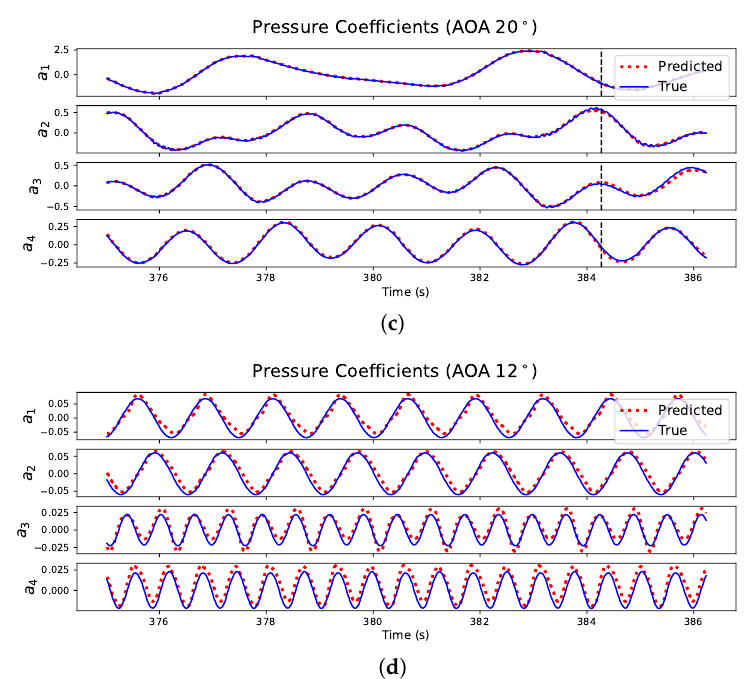
Figure 14. ( a ) the first four pressure coefficient at AOA 10 ◦ (vertical black line indicates the train test split). ( b ) The first four pressure coefficients at AOA 15 ◦ . ( c ) The first four pressure coefficients at AOA 20 ◦ . ( d ) The first four pressure coefficients at AOA 12 ◦ .